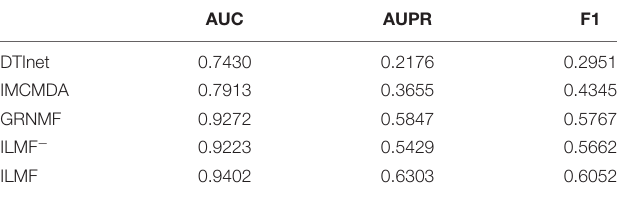
To ensure a fair comparison, the optimal parameters are selected from the ranges provided by these corresponding studies. For ILMF − and ILMF, the above